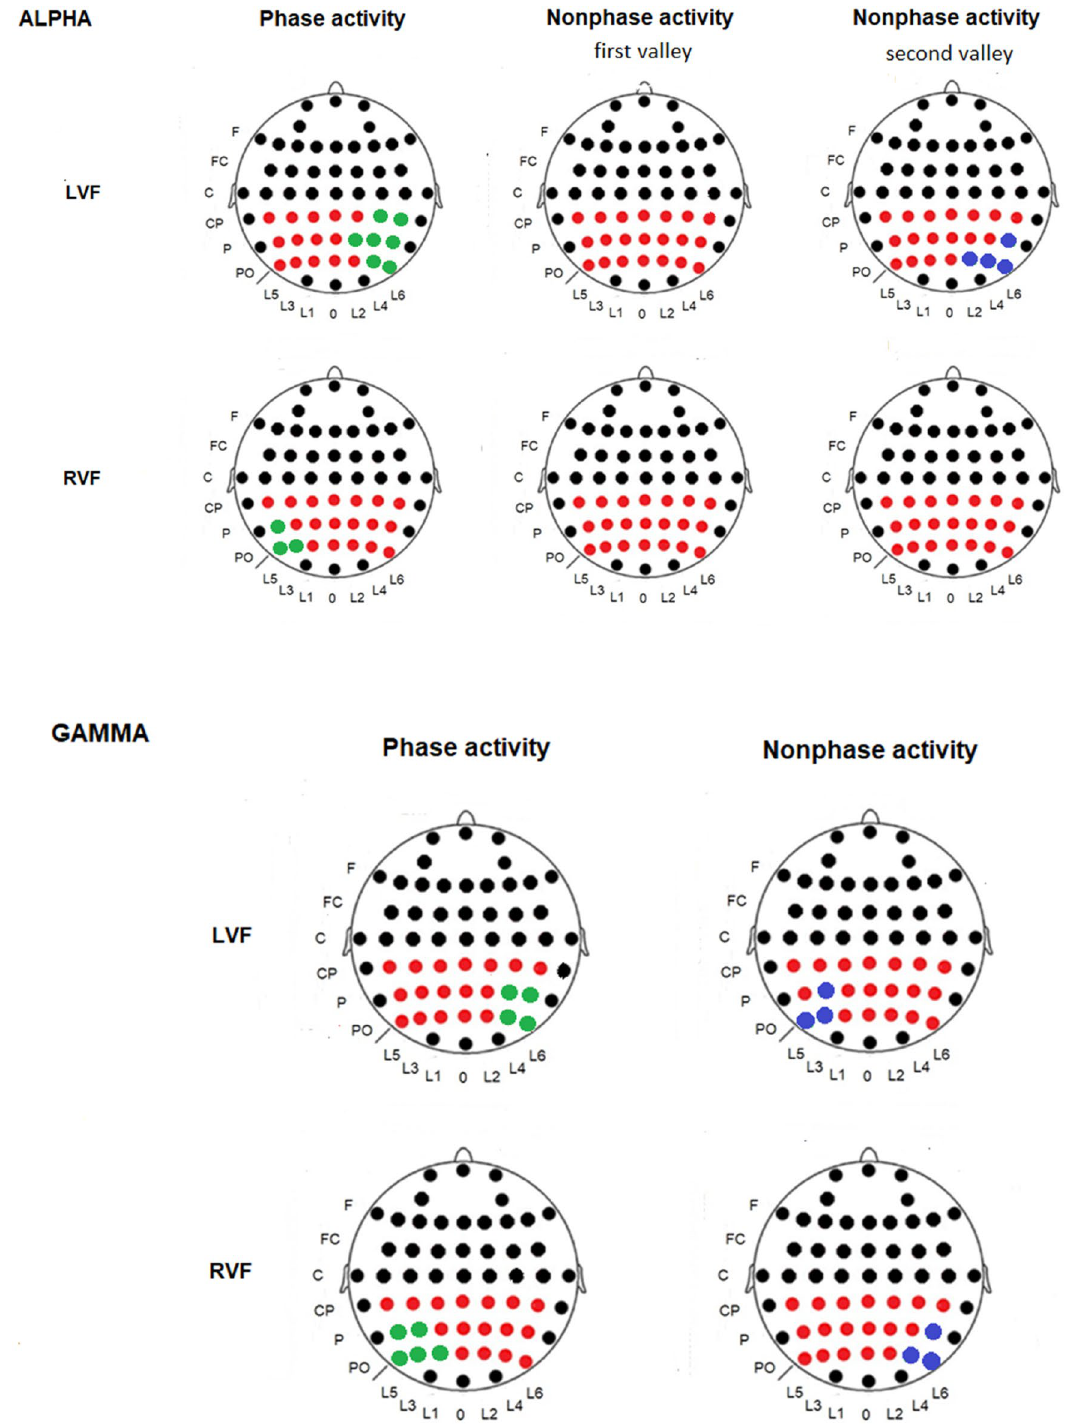
Figure 5. Significantly different electrodes from the alpha and gamma bands. Electrodes showing larger synchronization in the phase-locked response (green) and electrodes representing larger desynchronization in the nonphase-locked response (blue) compared to their homologous electrodes on the contralateral hemisphere. The first and second valleys correspond to different latencies in alpha desynchronization (see Table 1). Abbreviations LVF left visual field, RVF right visual